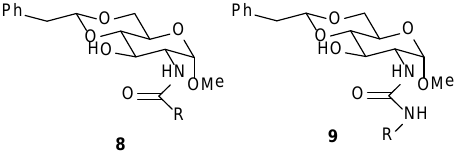
Figure 7. D ‐ glucosamine derived amides 8 and ureas 9 . Figure 7. D -glucosamine derived amides 8 and ureas 9 . Figure 7. D -glucosamine derived amides 8 and ureas 9 .